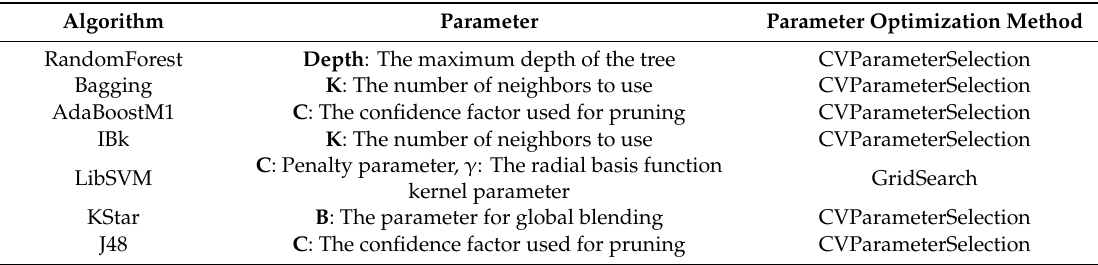
Table 2. Parameter